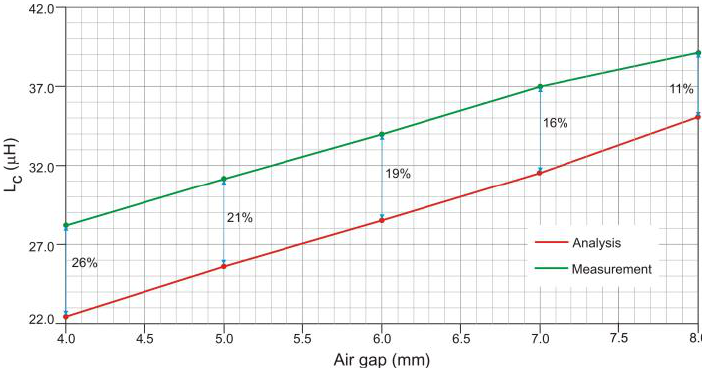
Figure 9. Leakage inductance vs. air gap.